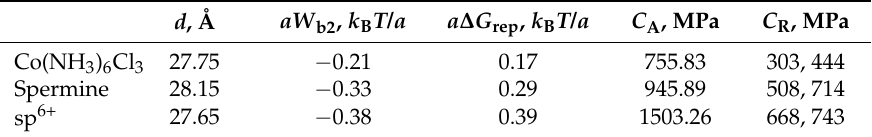
Table 1. Experimental data of double-stranded DNA (dsDNA) at different salt solutions [4] and the solved